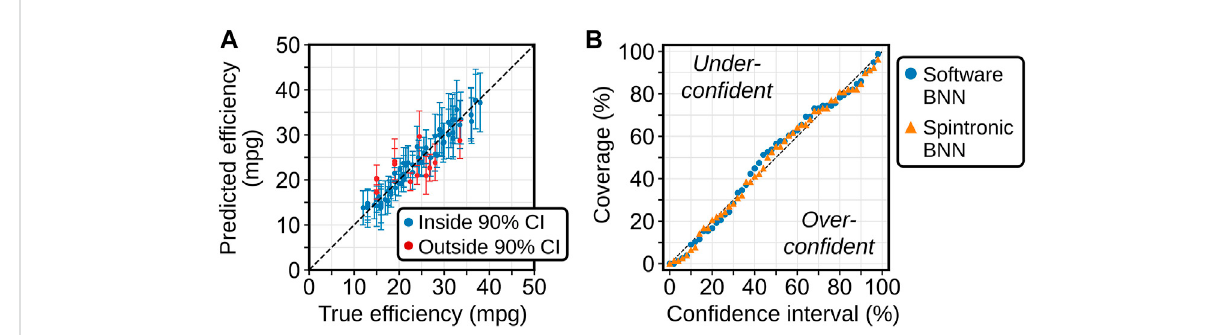
FIGURE 7 (A) SpintronicBNNregressionresultsontheAutoMPGtestset,comparingthepredictedtotrueef fi ciency.Errorbarsshowthe90%con fi